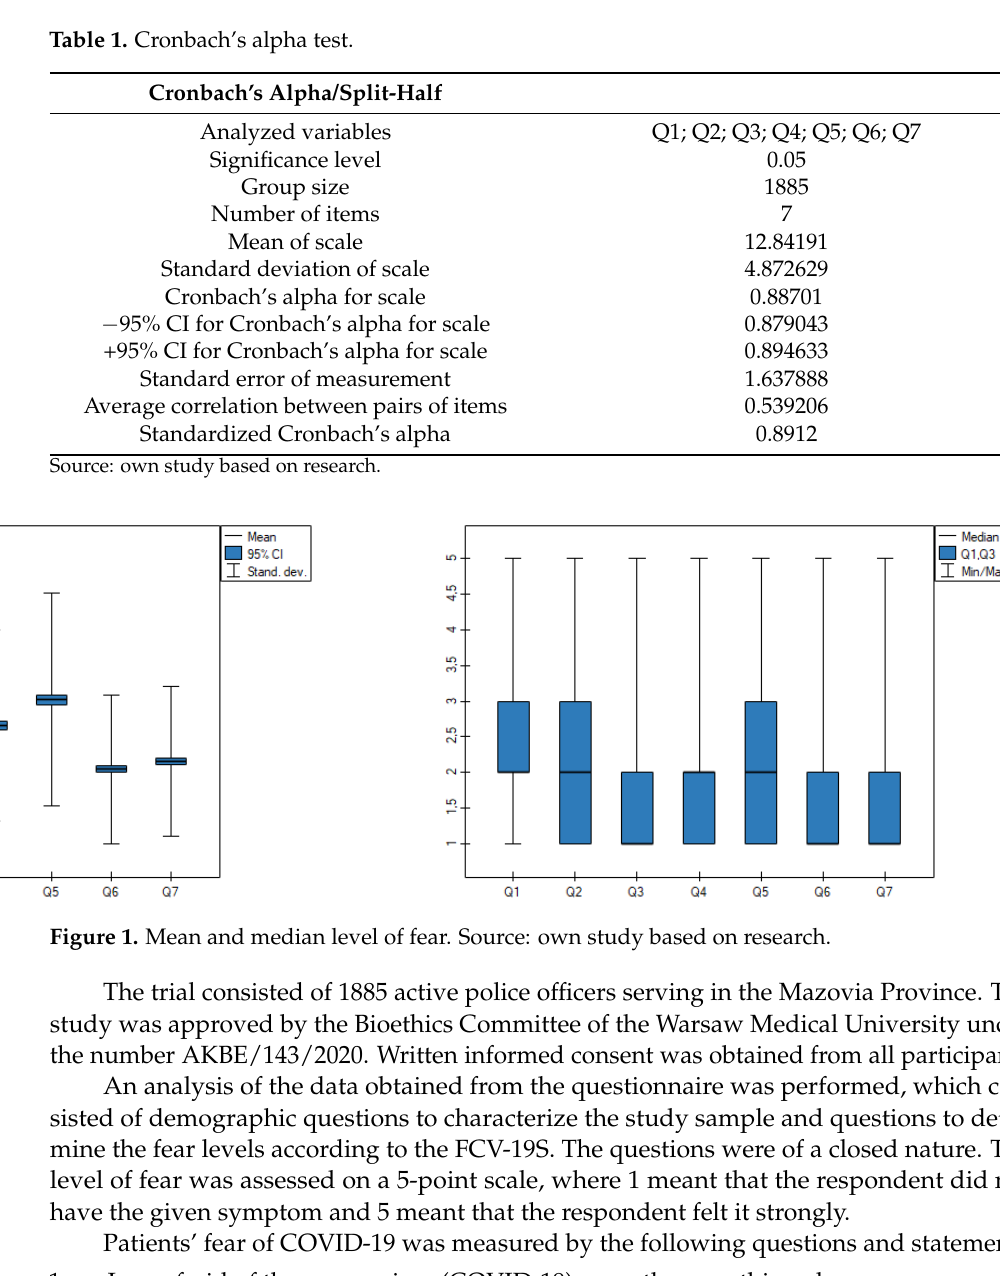
Table 1. Cronbach ’ s alpha test.